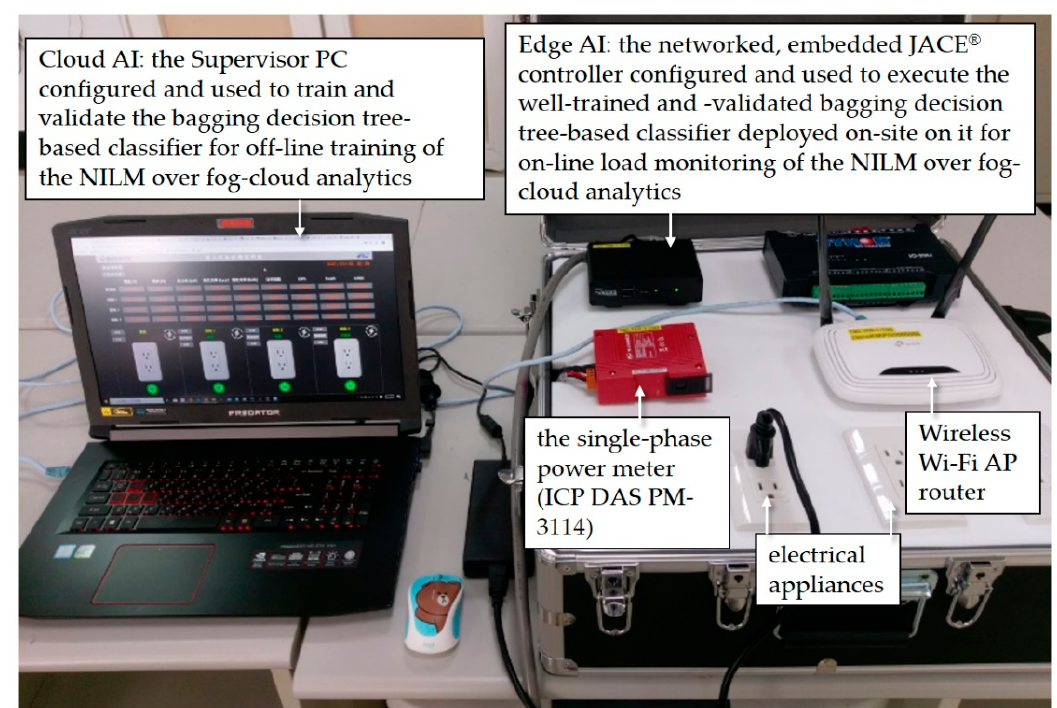
Figure 8. Experimental setup of the developed SHEMS prototype utilizing the presented two-stage NIALM approach over fog-cloud computing for the purpose of residential DSM. An electrical network topology with four power line branches in parallel is also shown.